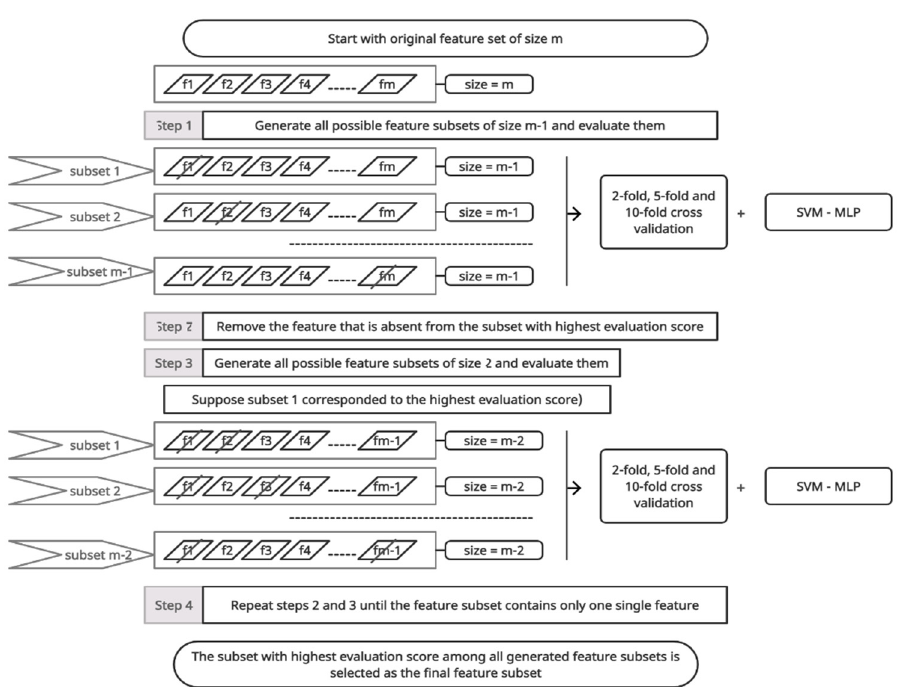
Figure 3. SFS flowchart.